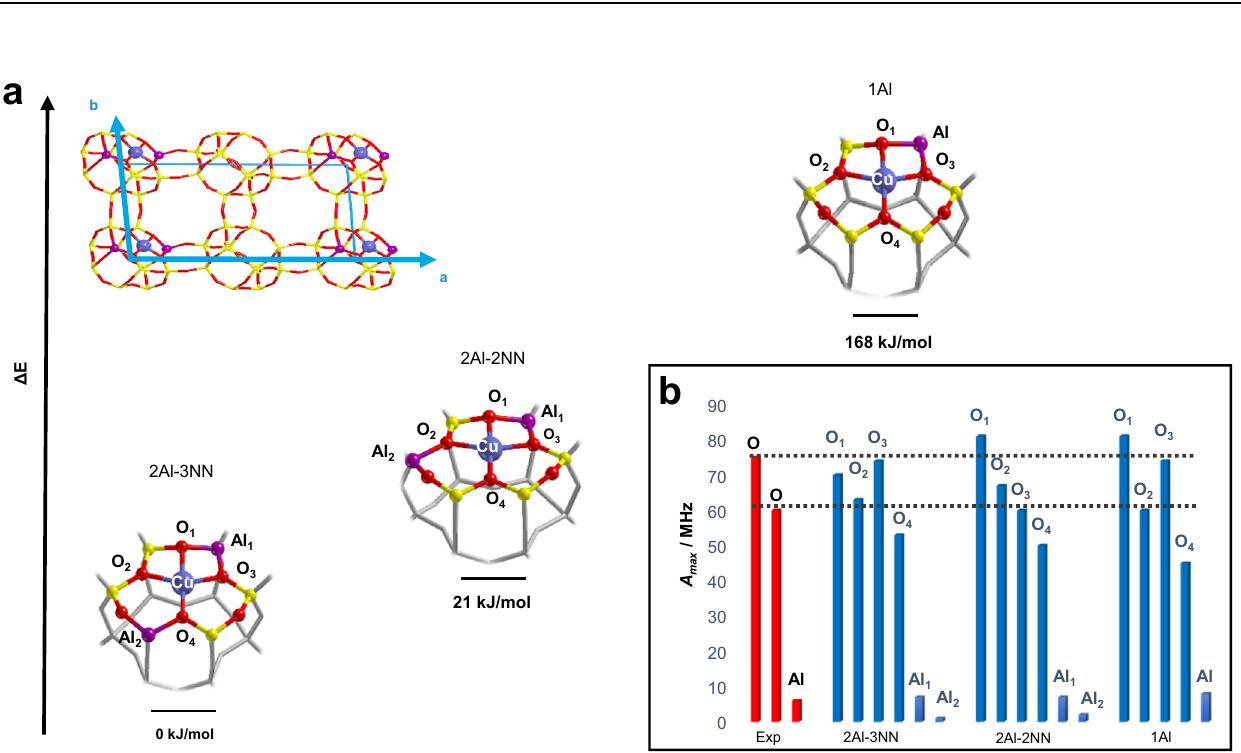
Fig. 4 Computed energetics and 17 O hyper fi ne couplings of relevant Cu-CHA structures. a B3LYP-D3(ABC)/pob-TZVP fully optimized structures of dehydrated Cu-CHA models (Si/Al = 11) by employing three different Al distributions, namely 2Al-3NN, 2Al-3NN and 1Al. The corresponding relative electronic energy per unit cell is shown for each structure. The unit cell (top left of the fi gure) is oriented according to the lattice vectors reported in cyan. b Comparison of experimental (red) and computed (blue) maximum hyper fi ne coupling values ( A max ) for 17 O and 27 Al nuclei for the three different Al distributions illustrated in ( a ). The black dashed lines represent the experimental range of A max for 17 O